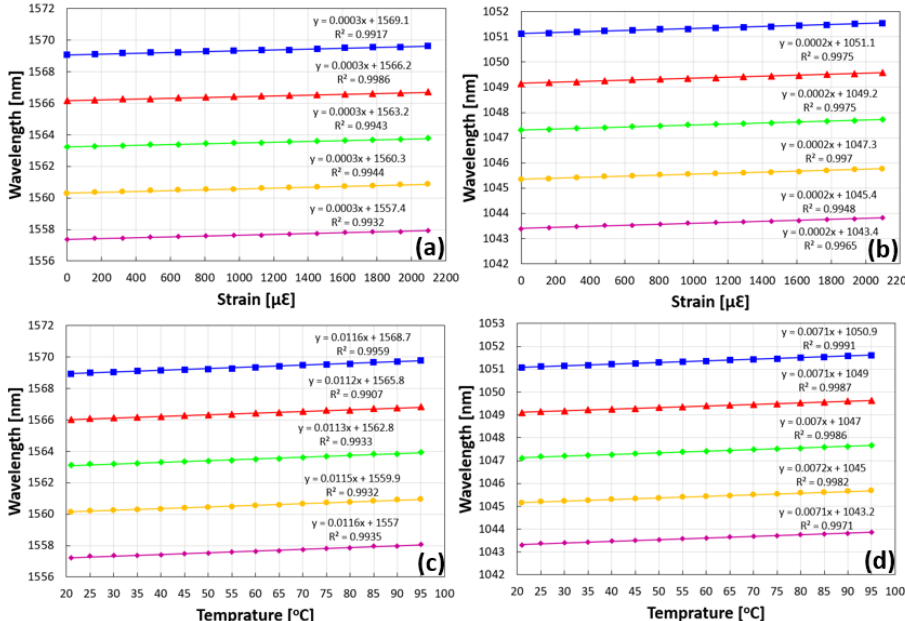
Figure 5. The measured wavelength sensitivity to strain ( a , b ), and temperature ( c , d ) for the five FBG array. ( a ) All five peaks show a strong linear dependence on strain with a similar sensitivity of 0.3